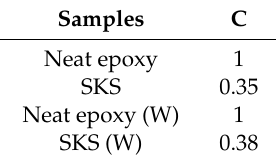
Table 3. Reinforcement effectiveness (C) of neat epoxy and SKS composite.